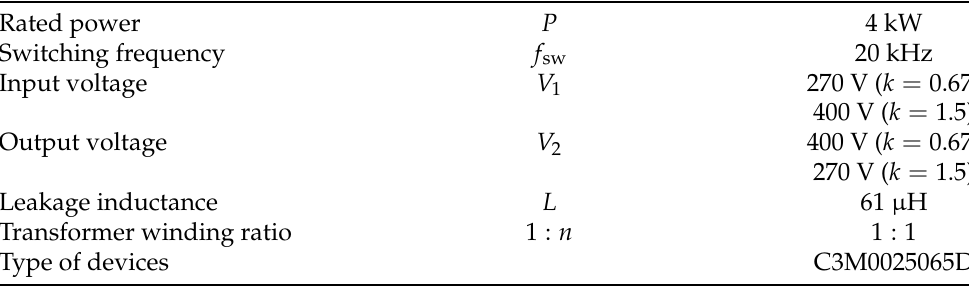
Table 2. Specifications of 4 kW Prototype of DAB